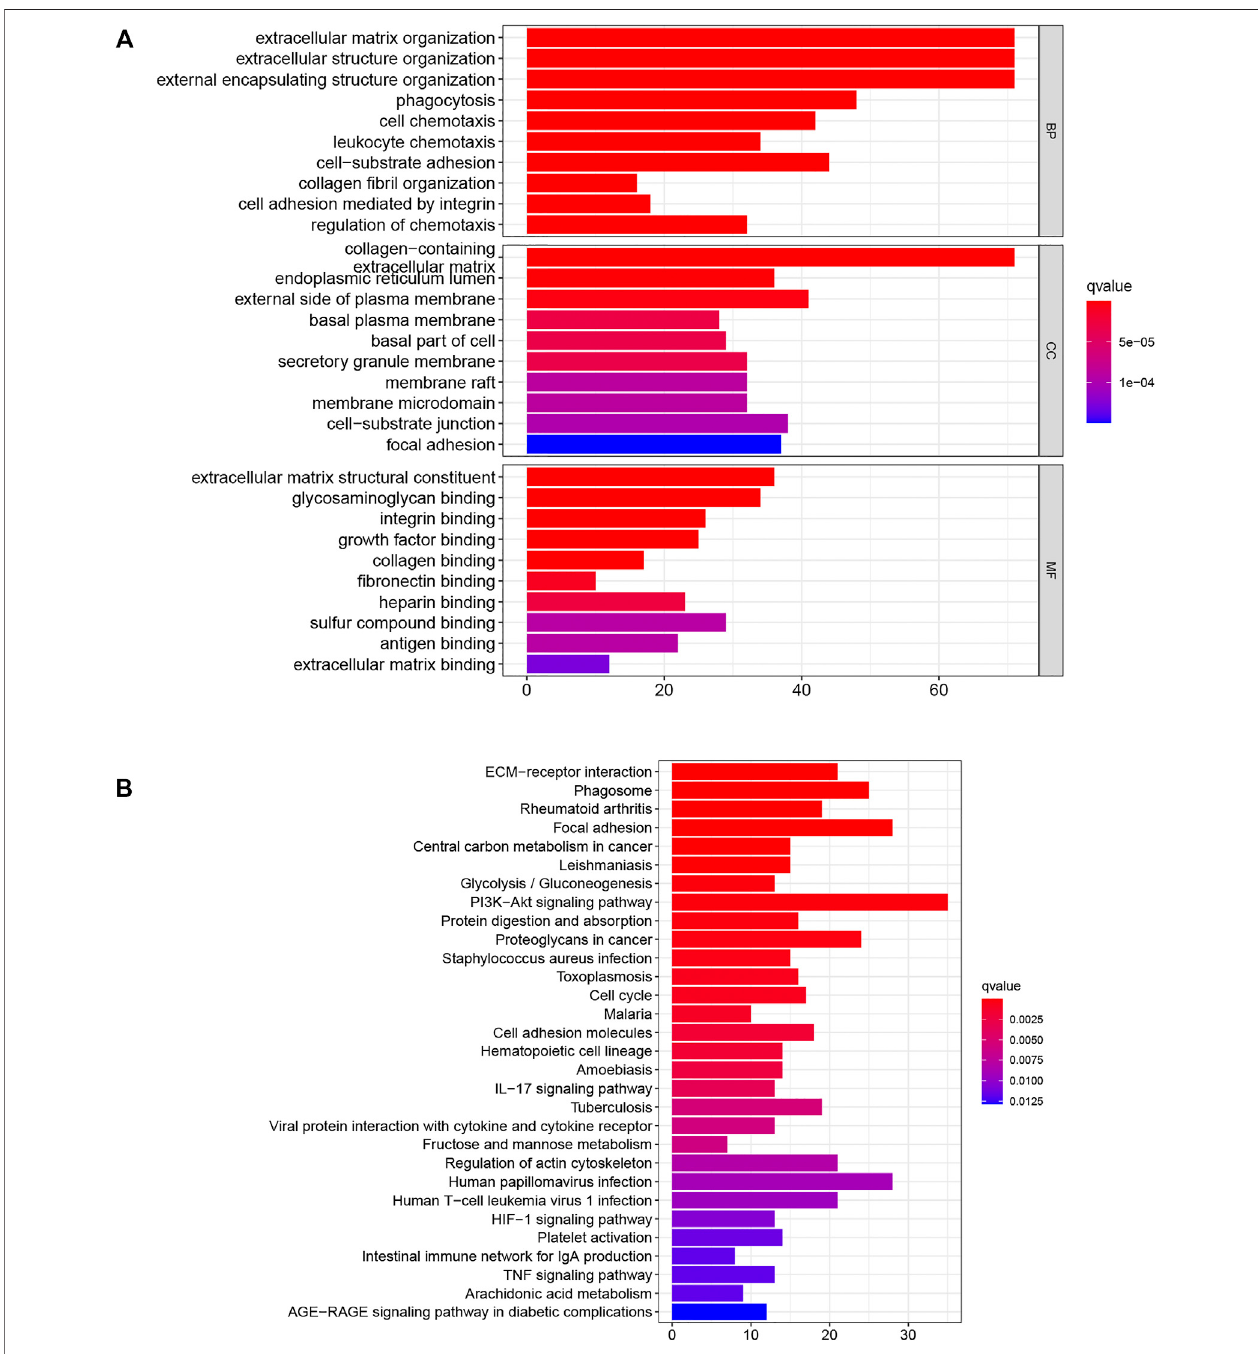
FIGURE 10 | DENRG enrichment in the training set (A) GO (B) KEGG. BP Biological process, CC Cellular component, MF Molecular